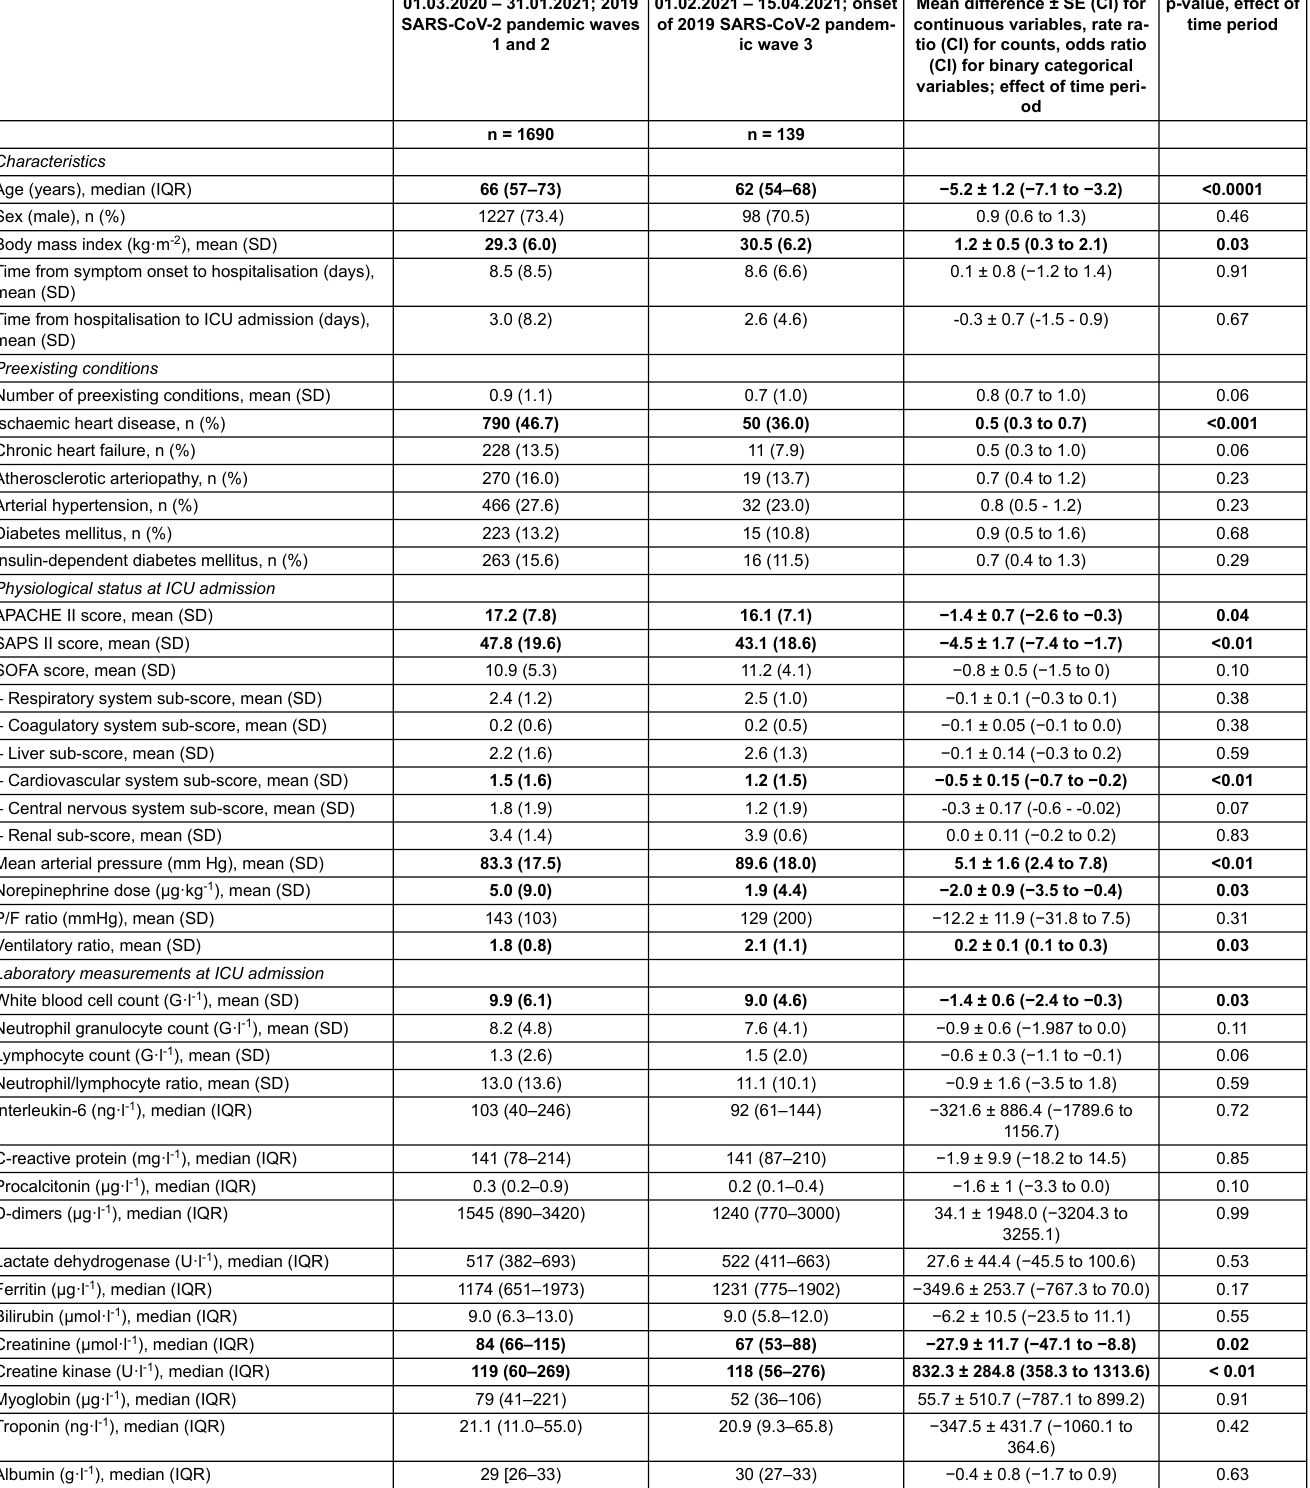
Table 1: Characteristics of critically ill COVID-19 patients at ICU admission at the onset of the third wave of SARS-CoV-2 infections in Switzerland in comparison with the previ- ous pandemic